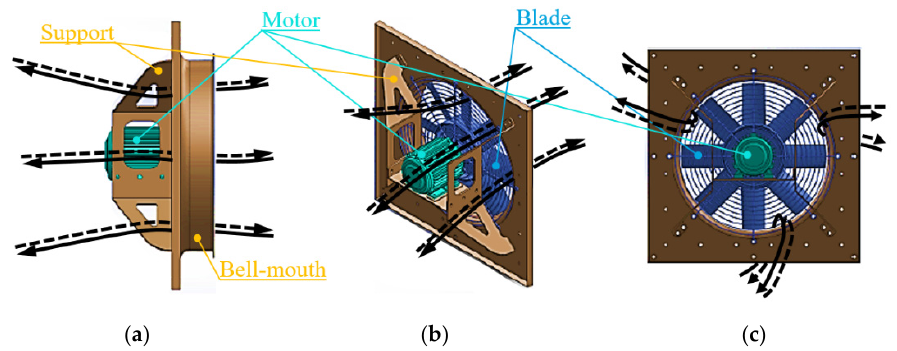
Figure 1. Typical assembly of a wall-mounted axial fan: ( a ) side view; ( b ) three-dimensional (3D) view; ( c ) front view.